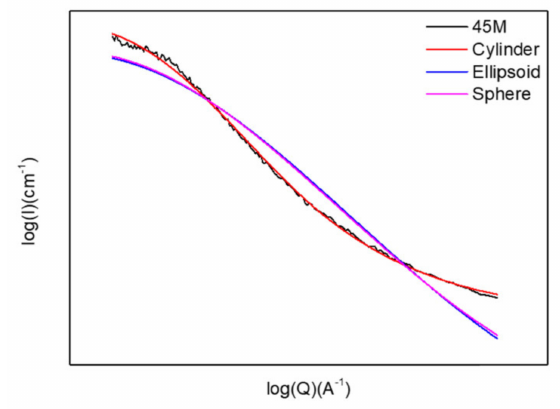
Figure 12. Intensity versus q xy for the 45M organosilicate glass film and the fitting curves of the cylinder, ellipsoid and sphere pore models, where M is the methylene bridge